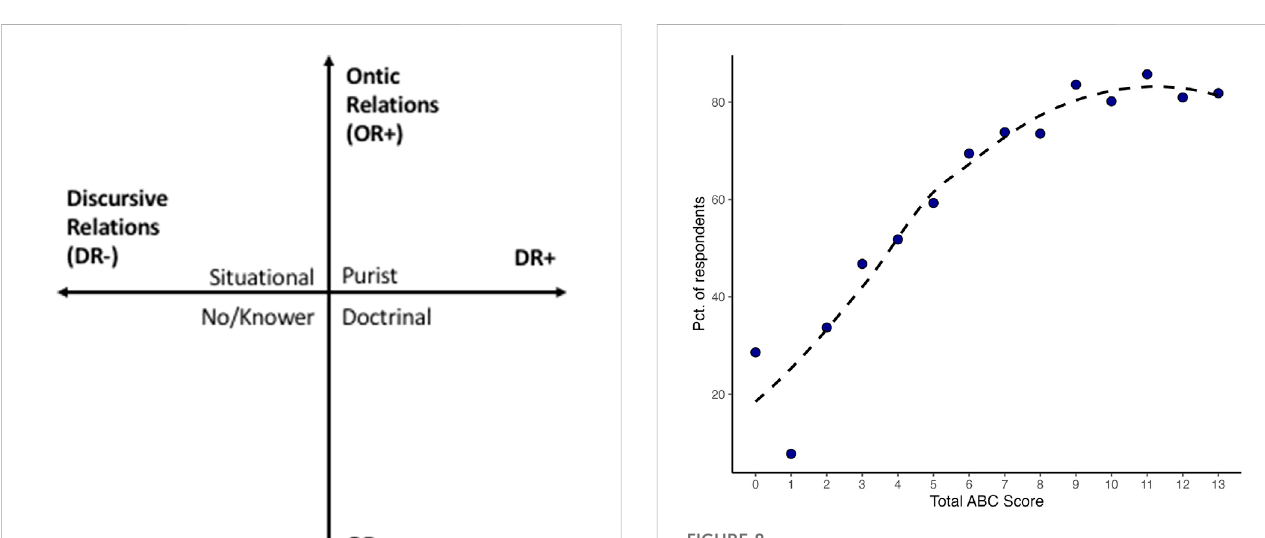
FIGURE 8 Farming is an occupation with good fi nancial returns question (yes or no) from the ABC of soil survey. Taken from Johnson et al